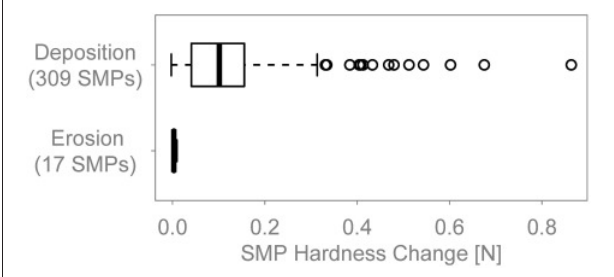
FIGURE 5 | Boxplots comparing SMPs that were acquired in positions were snow was either deposited or eroded.